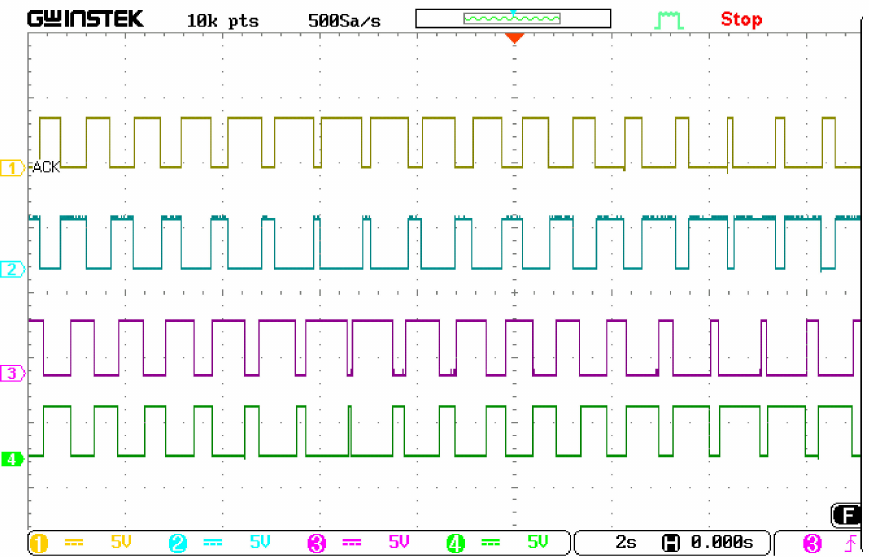
Figure 1. PWM outputs for two sinusoidal signals with 1 Hz frequency and a 120 degree shift with 1 µ s dead-time: (Cha-1, 3) a and b signals, (Cha-2, 3) inverted correspondent of a and b. The level